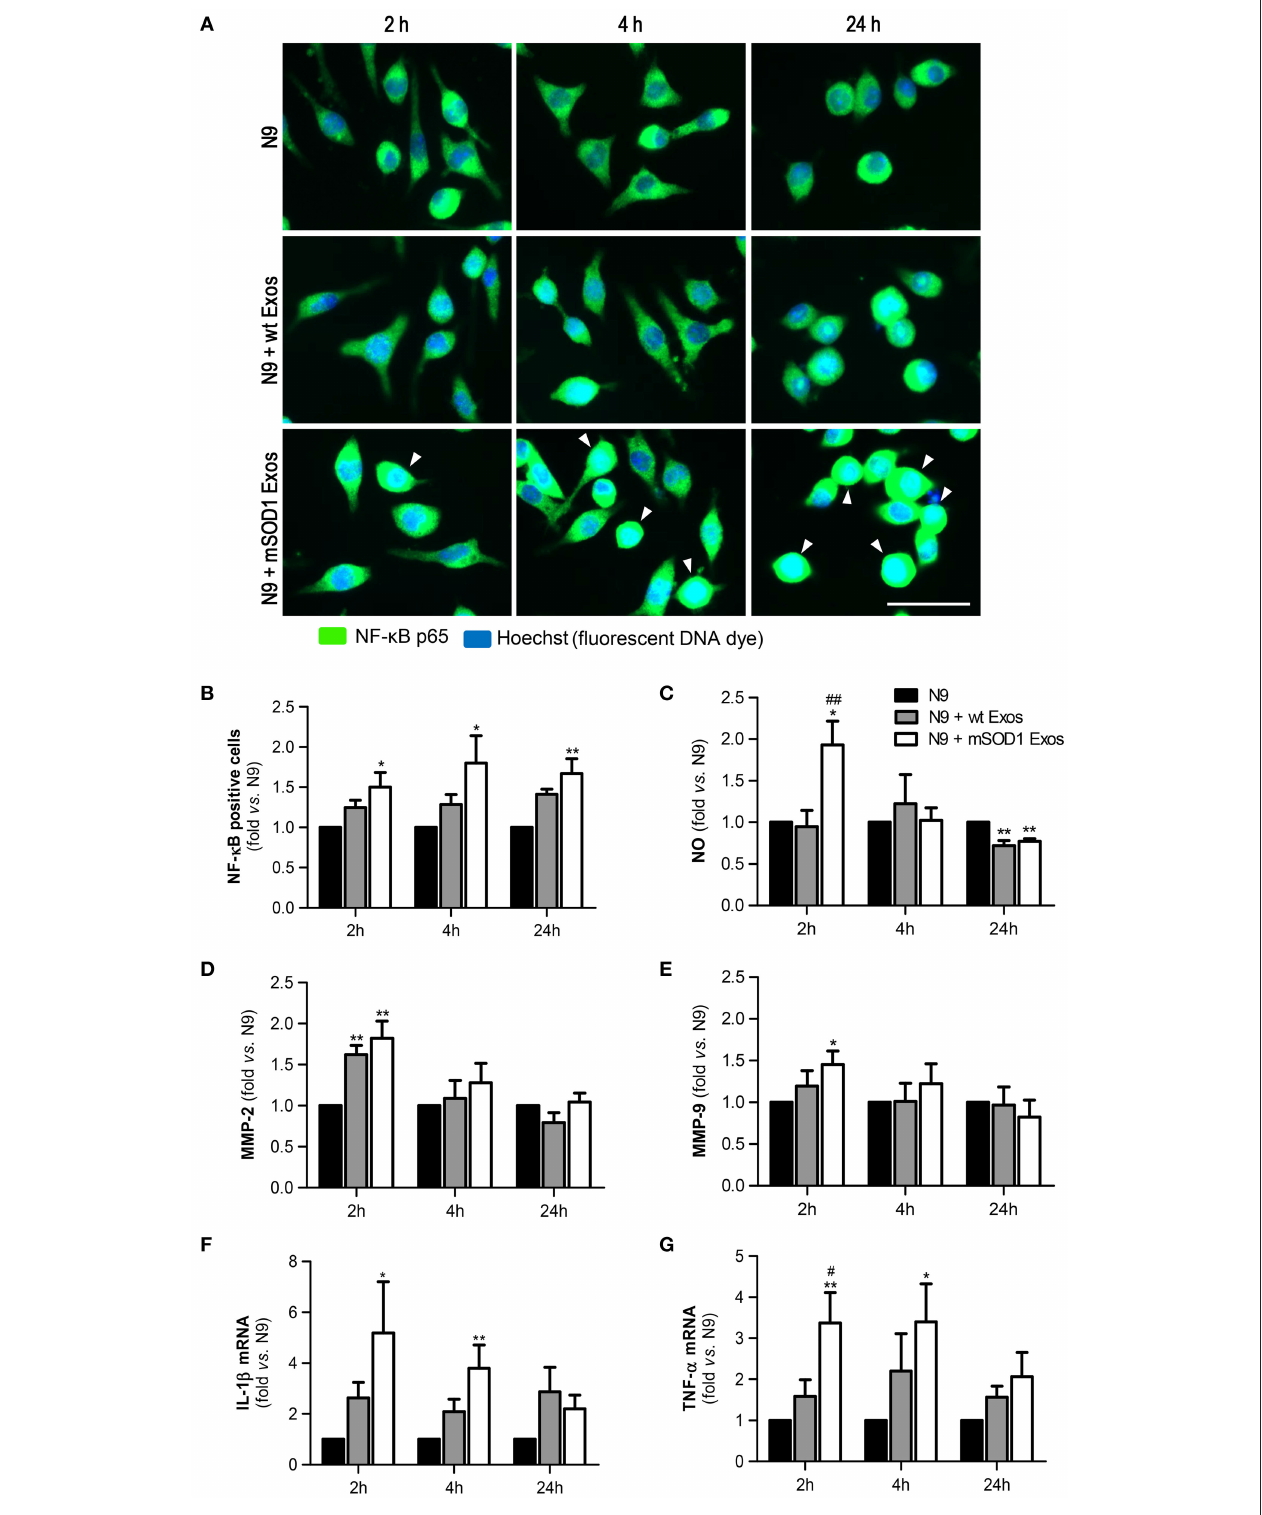
FIGURE 4 | Exosomes derived from NSC-34 motor neurons (MNs) mutated in G93A (mSOD1) lead to sustained NF- κ B activation and acute production of inflammatory mediators in the recipient N9 microglia. N9 cells were incubated for 2, 4, and 24 h with exosomes (Exos) from wild-type (wt) NSC-34 MNs